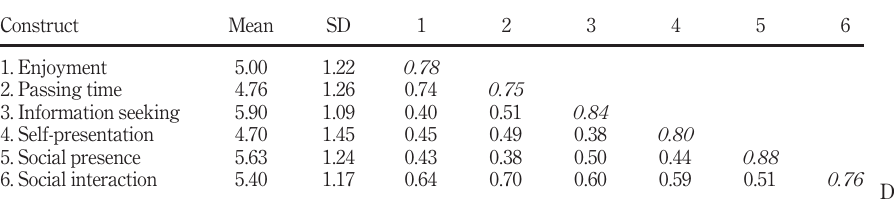
Table IV. Discriminant